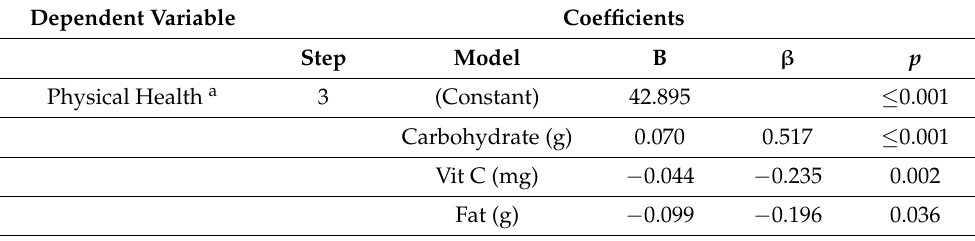
Table 4. Multiple linear regression models to identify factors associated with QoL among adolescent girls in the Jatinangor District, a rural area of